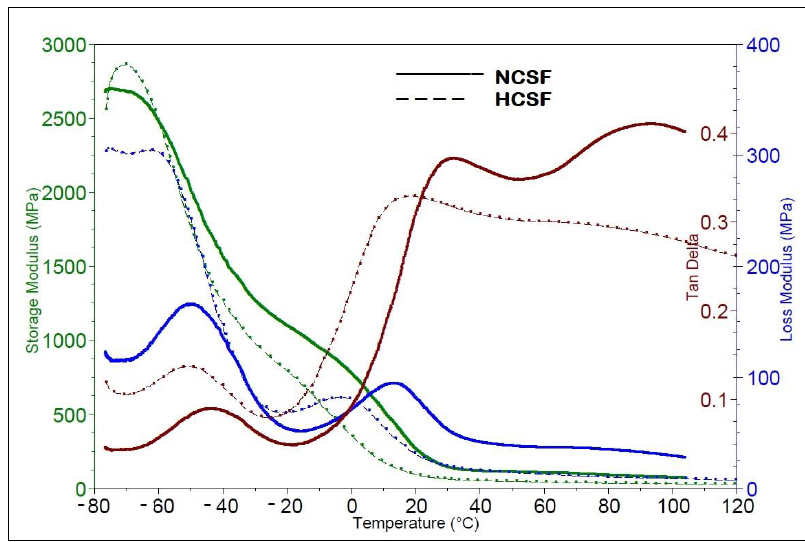
Figure 9. Storage modulus and tan δ plots for the native corn starch film (NCSF) and hydrolyzed corn starch film (HCSF). Table 8. DMA analysis results.